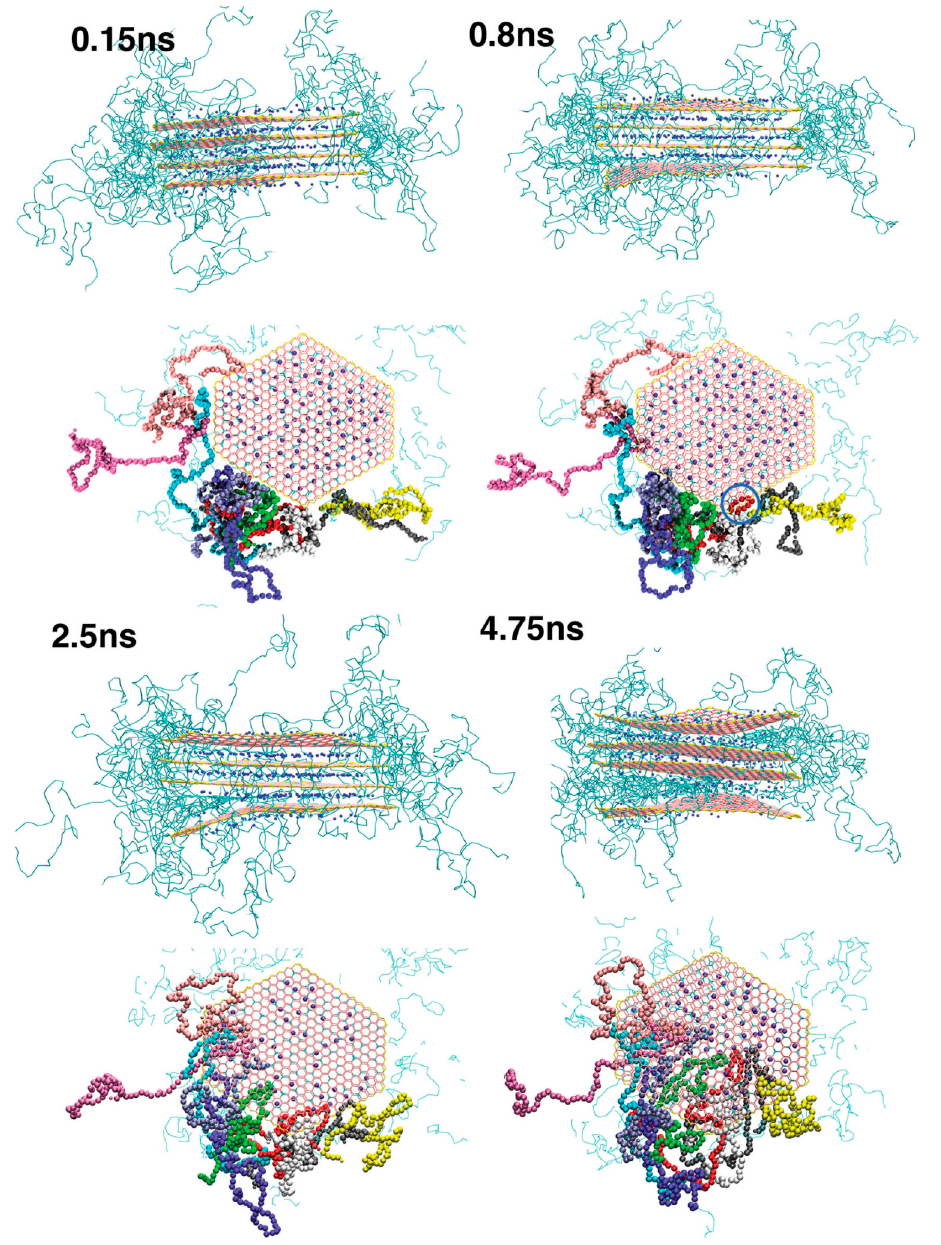
Figure 2. Pictorial overview of the intercalation of poly(vinyl alcohol) chains in a clay tactoid. The side and top views of the tactoids are illustrated at several snapshots. The macromolecules are shown by the green bonds in the side views. The color code for the clay particles are: pink: neutral clay; cyan: charged clay; yellow: edge of the clay; and blue: sodium. The bending of the lowermost clay due to the intercalation process of poly(vinyl alcohol) chains can be observed in the side view snapshots. For the top view, the intercalating polymers are colored based on their molecule number, to make the visualization easier. One can see that the polymer initially starts intercalating as short loops (for an instance see the blue circled chain at the 0.8 ns snapshot), and progresses further into the interlayer. Reprinted from Suter et al. [293] under the terms of the Creative Commons Attribution License.